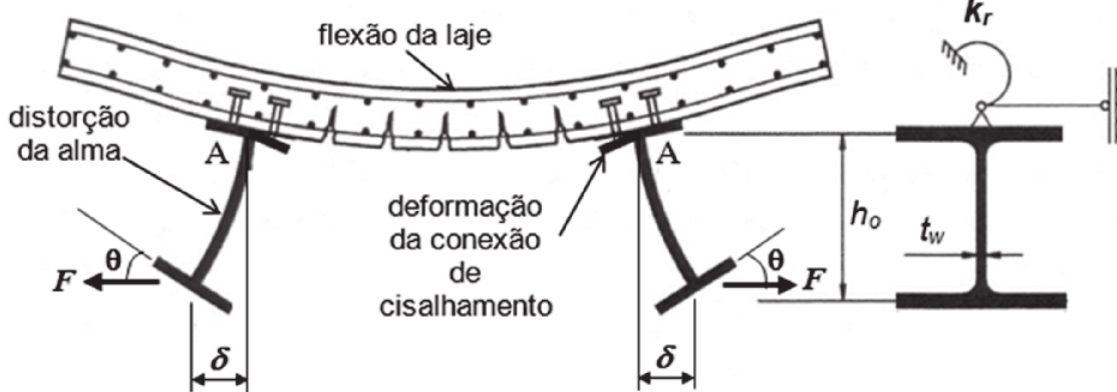
Rigidez rotacional de uma viga mista [4] Adaptada pelos autores